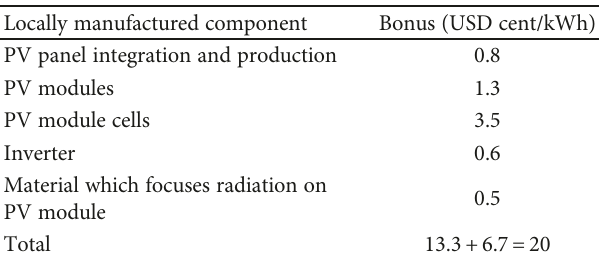
Table 2: Feed-in tari ff and incentives, locally manufactured components, and PV